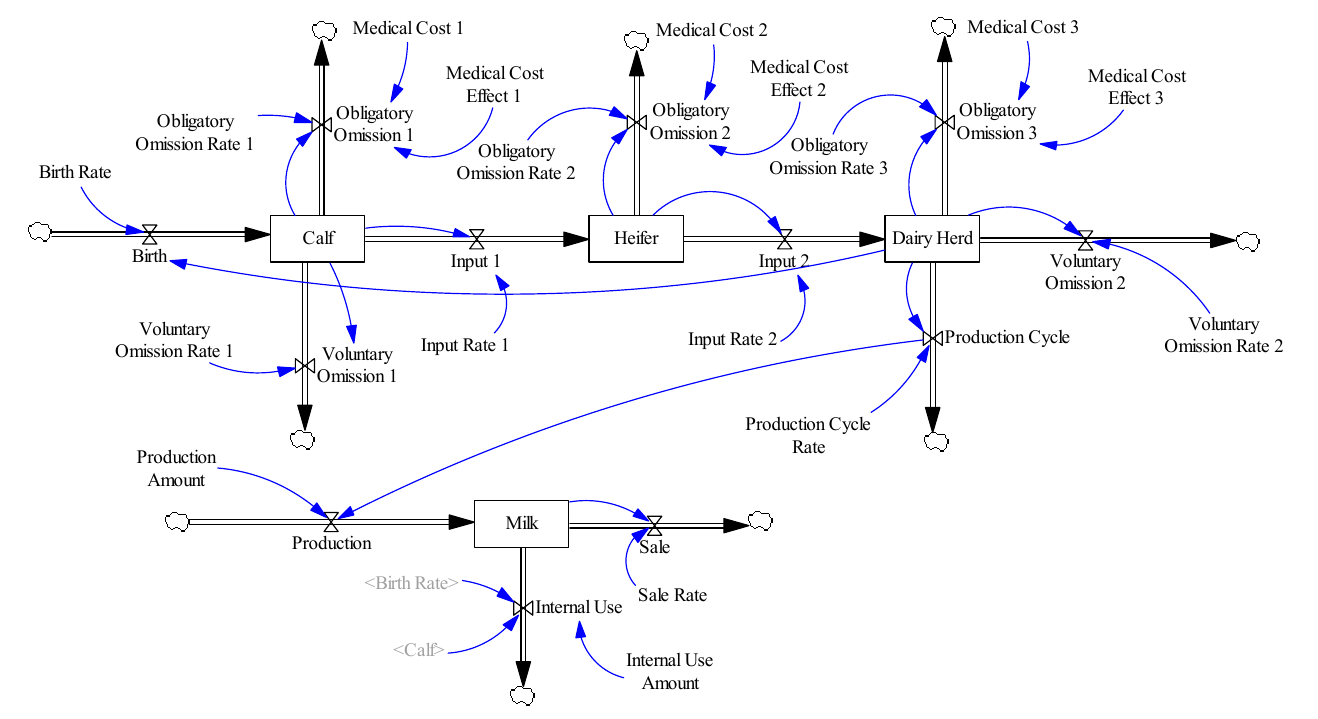
Figure 5. Stock–flow diagram of the Fereidan Ahrar ranch.